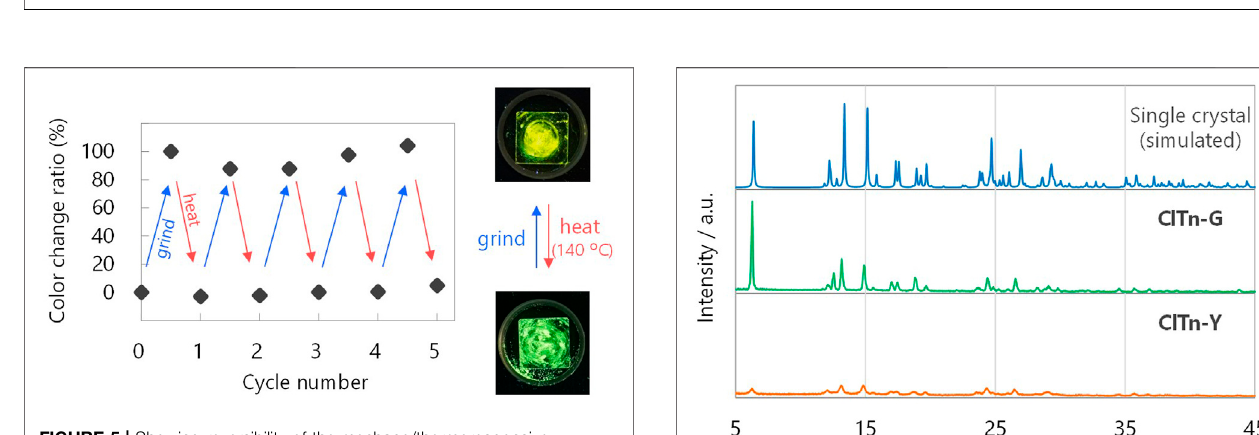
FIGURE4| PLdecaycurvesfor (A)ClTn-G and (B)ClTn-Y atroomtemperatureinair.Theblacklinesare fi ttedcurves.PLintensitieswererecordedat520 nmfor ClTn-G and 560 nm for ClTn-Y ( λ ex (cid:2) 368 nm). The bracketed lifetime < τ > is the area-weighted lifetime.